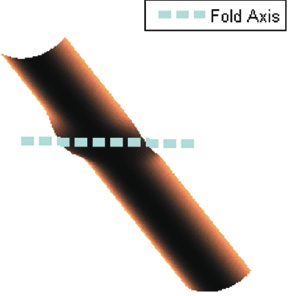
Fig. 1. The tape spring is concave except at the fold axis which can slide and rotate. The low stiffness about the fold axis allows for